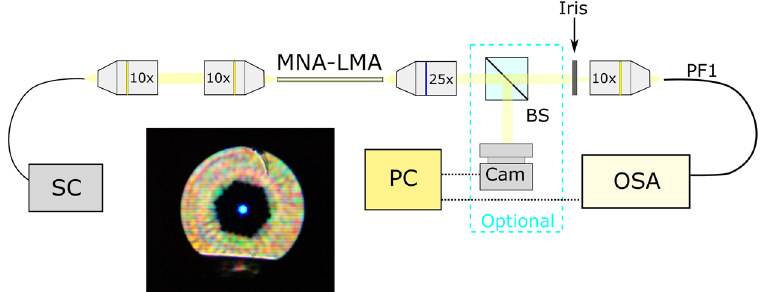
Figure 7. Experimental setup for the acquisition of the transmission spectra of the MNA-filled LMA-10 fiber. Inset (black box): Near field image of the MNA-LMA fiber output (without iris application for blocking the cladding